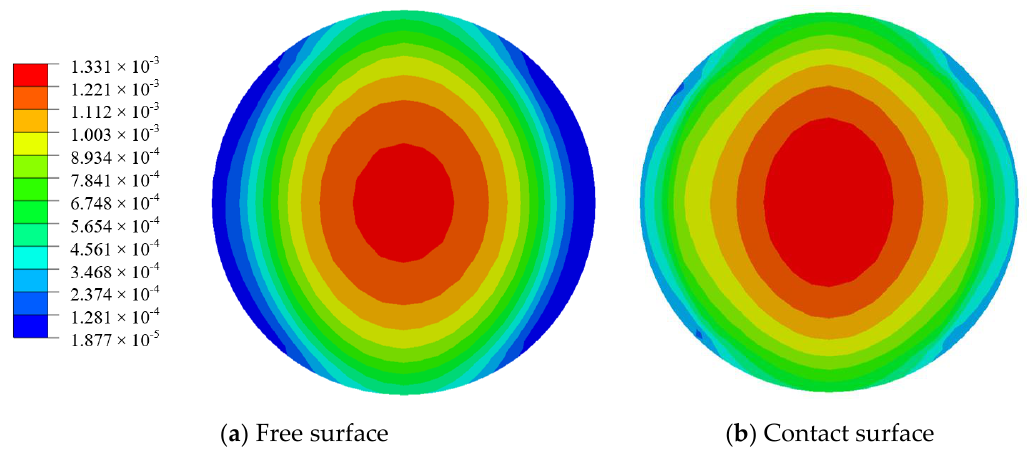
Figure 5. The strain distribution of PZT calculated by FEA when the strain of host structure is 2000με.